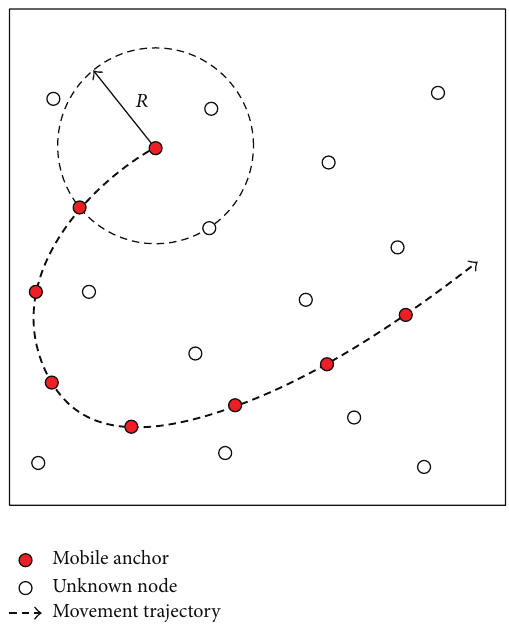
Figure 2: Network